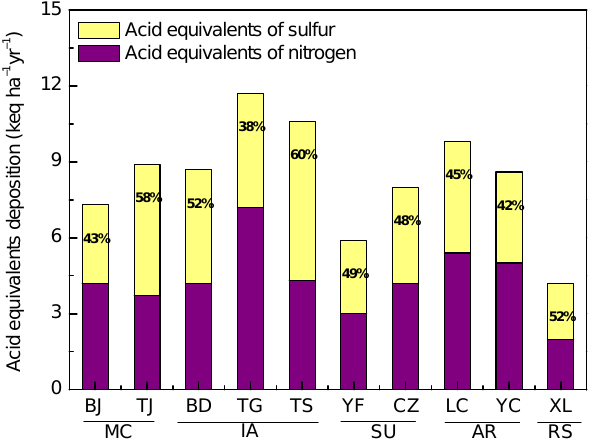
Fig. 5. Total “acid equivalents” deposition of sulfur and nitrogen at the ten selected sites in Northern China. The data shown are means of 3-yr observations. MC, IA, SU, AR and RS denote urban, indus- trial, suburban, agricultural and rural sites, respectively. Percentage in each bar represents the proportion of sulfur contribution to acid equivalent deposition at the corresponding site. The definition of the site codes is found in Sect.